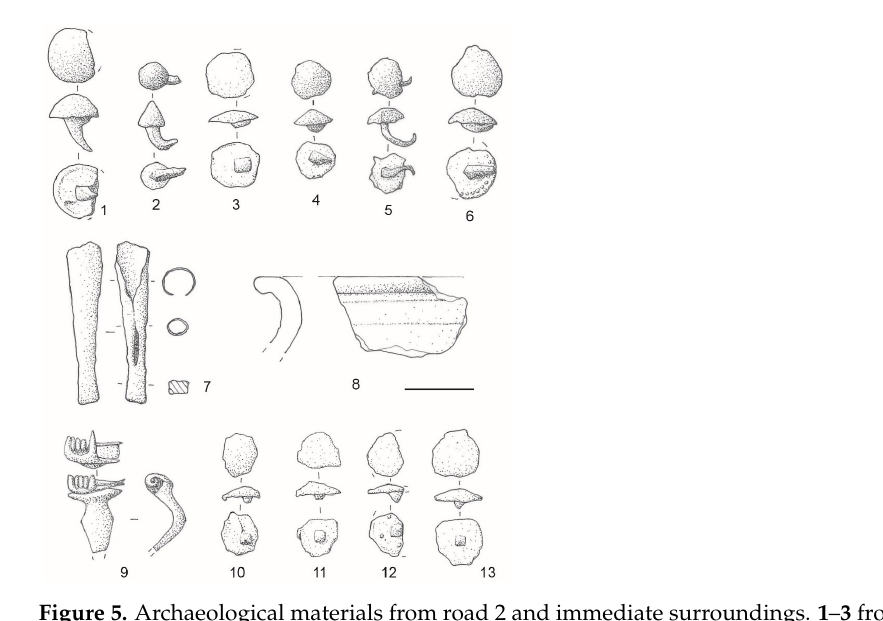
Figure 4. Zoomed view of area A of Figure 2 with the position of road tracks indicated by white arrows in the upper picture (local relief model of an ALS-derived DTM) and by black lines in the lower one (hill-shaded image of an ALS-derived DTM). White circles: caliga hobnails; white lines: modern roads.